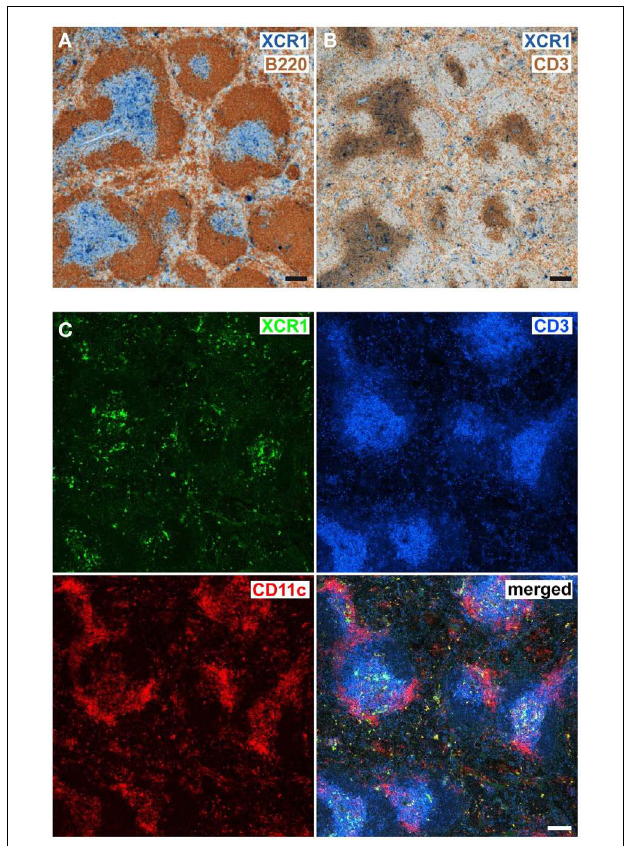
FIGURE 2 | Splenic XCR1 + DCs are localized in theT cell zone, marginal zone, and the red pulp. Serial cryostat sections of C57BL/6 spleens were double-stained for (A) XCR1 (blue) and B220 (brown), or (B) XCR1 (blue) and CD3 (brown) using standard immunohistology, or (C) triple-stained for XCR1 (green), CD3 (blue), and CD11c (red) with fluorescent mAb and analyzed by confocal microscopy (Bars = 100 µ m). Shown are representative images of two